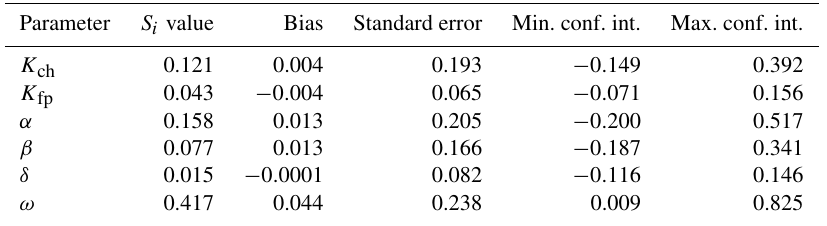
Table A1. Sobol first-order indices for the six parameters of MHYST. Confidence interval is denoted as conf. int. here.